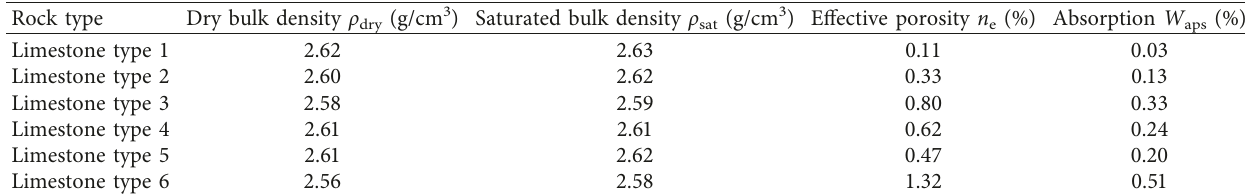
Figure 3: The microstructure of samples: (a) limestone 1; (b) limestone 2; (c) limestone 3; (d) limestone 4; (e) limestone 5; (f) limestone 6. Table 1: Mean physical characteristics of studied rock